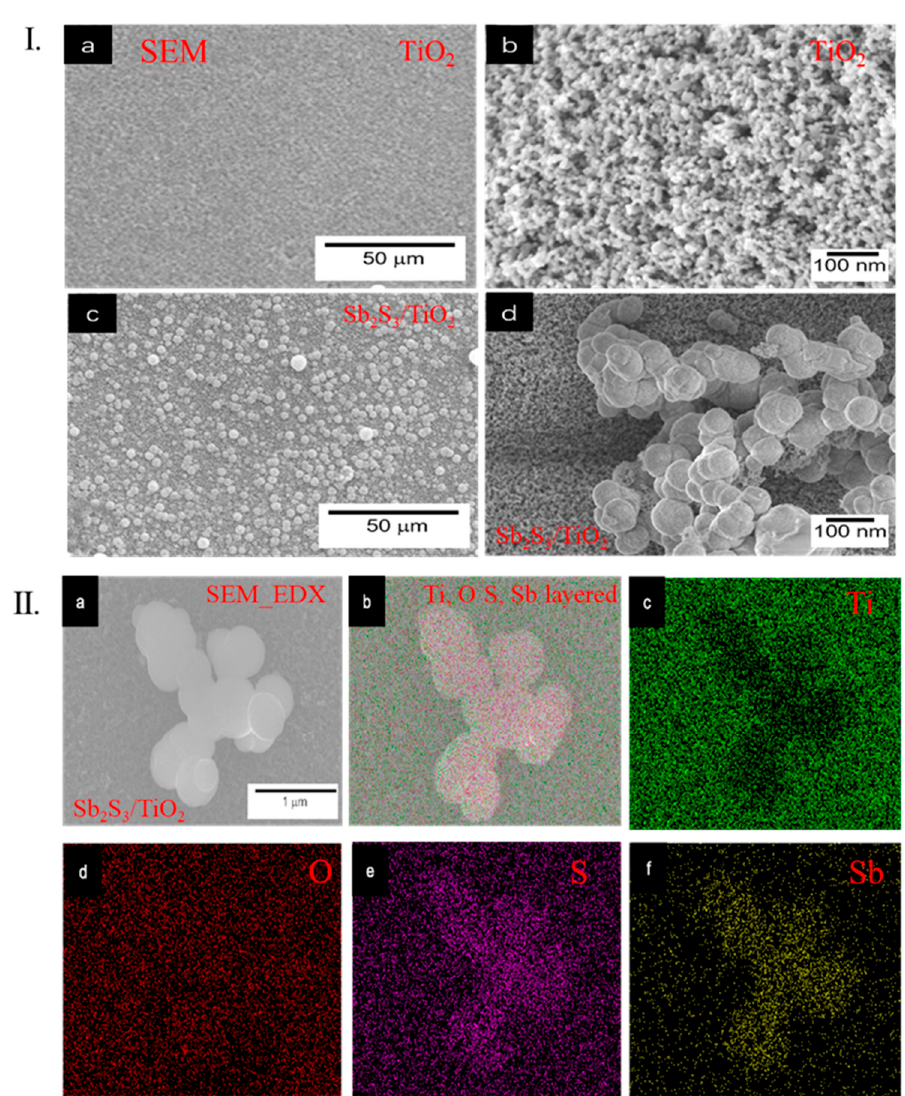
Figure 4. (I) SEM images; ( a , b ) TiO 2 and ( c , d ) Sb 2 S 3 /TiO 2 electrode, respectively; ( II ) ( a ) SEM_EDX elements distribution mapping images of the Sb 2 S 3 /TiO 2 electrode; ( b ) Ti, O S, Sb layered, ( c ) Ti, ( d ) O, ( e ) S, and ( f ) Sb, respectively.